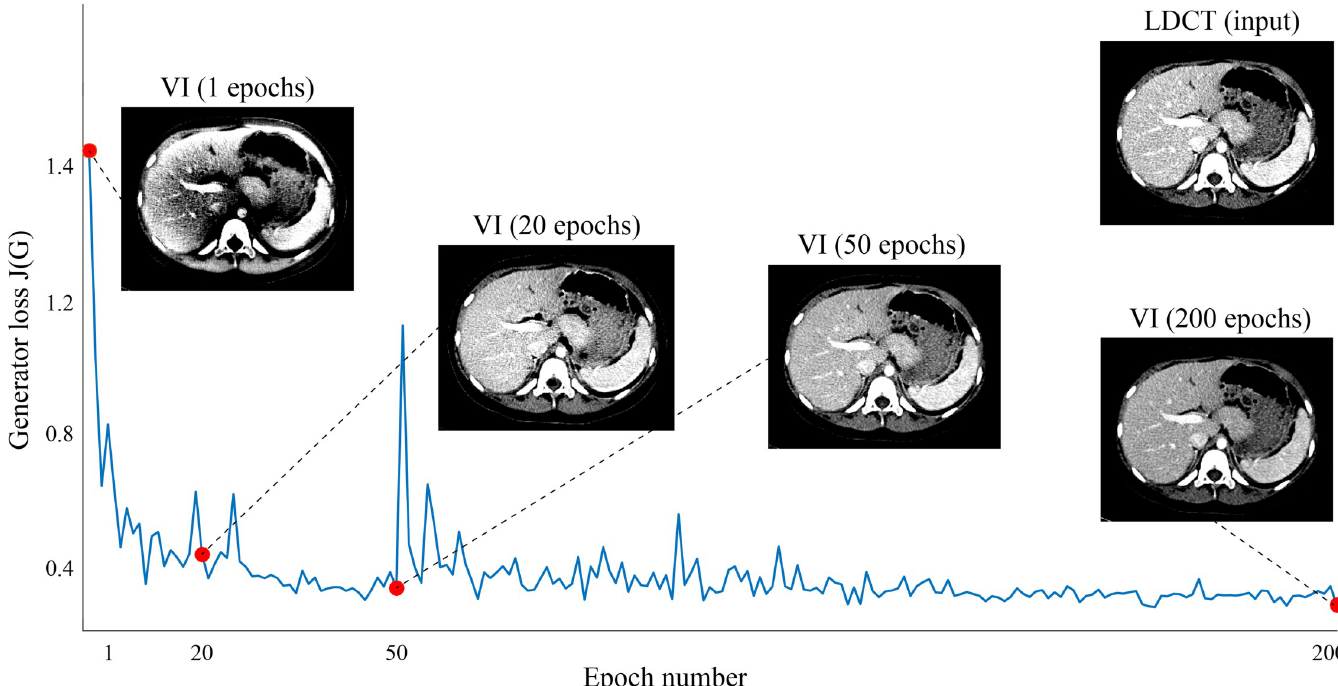
Fig 4. Graph of generator loss over the number of epochs, and the generated virtual SDCT images (VIs) at each epoch during the training process. (See Eq. (2) in the S1 File section for a mathematical expression of the generator loss J(G)).